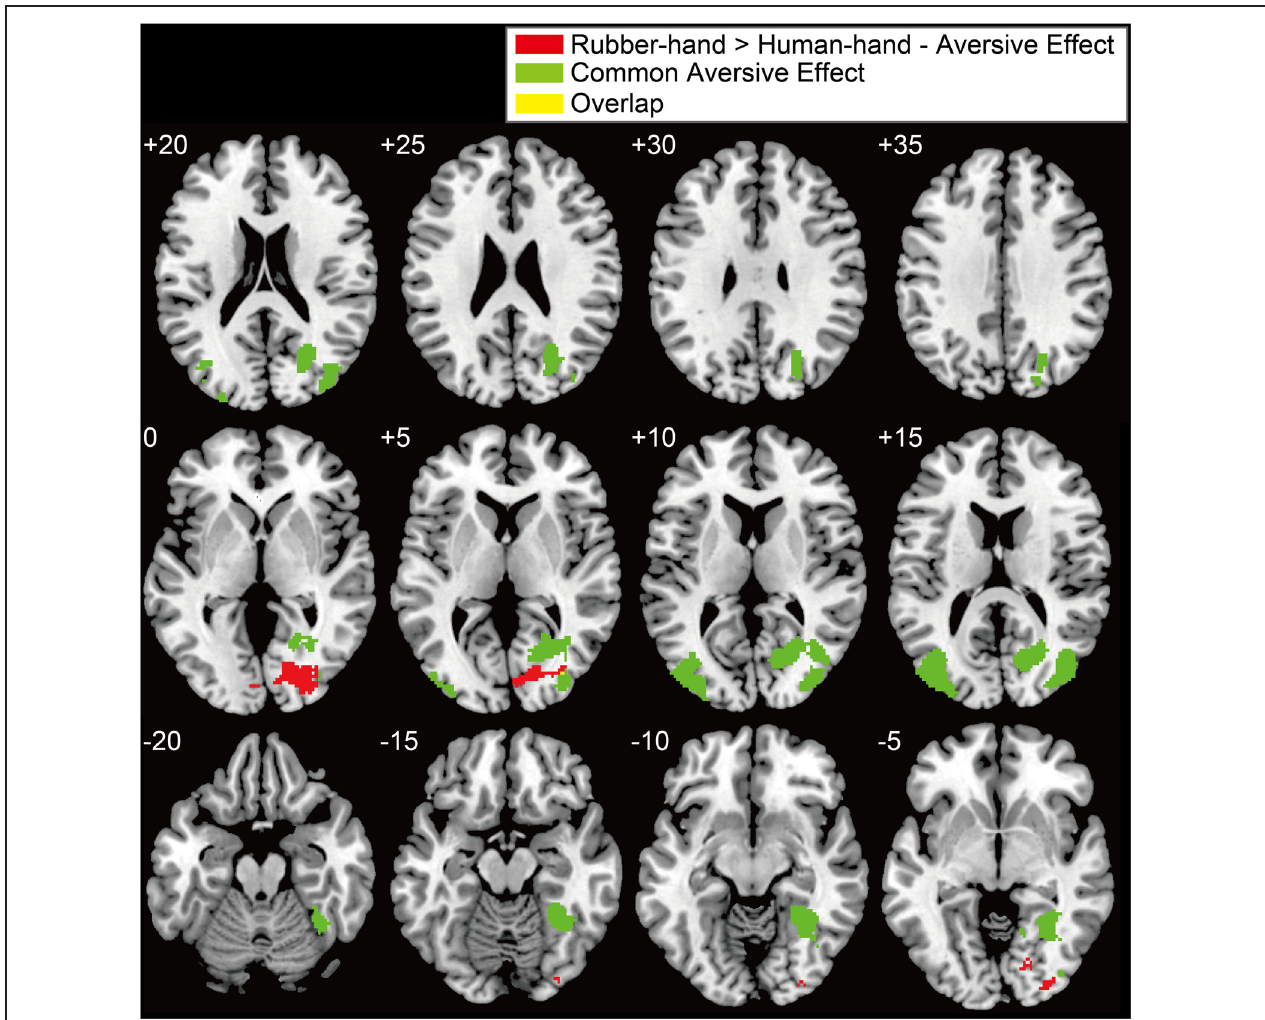
FIGURE 3 | Significant activation for the interaction between hand and aversiveness conditions (rubber-hand > human-hand − aversive effects) and common aversive effects. Red, green, and yellow clusters showed interaction effects, common aversive effects, and overlapped